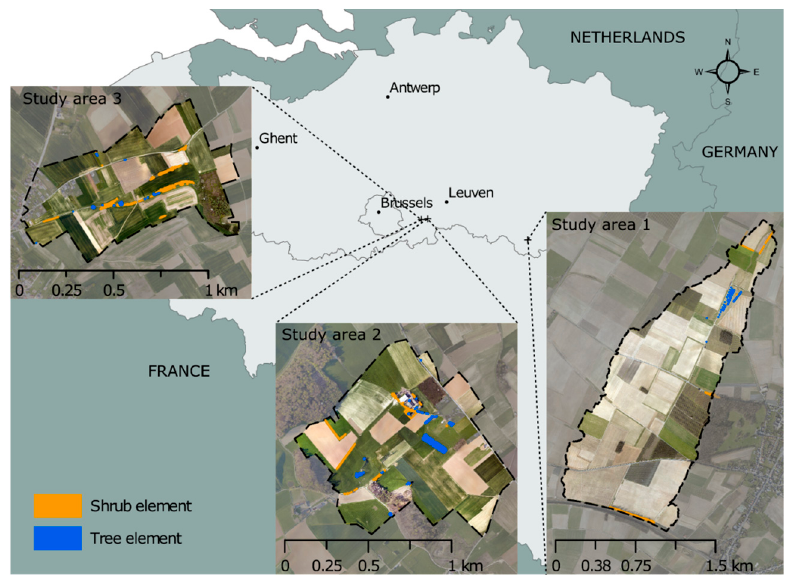
Figure 2. Location of the three study areas within the Flanders region, Belgium. The orange and blue polygons on the inset orthophotographs represent the shrub and tree elements measured in the field.